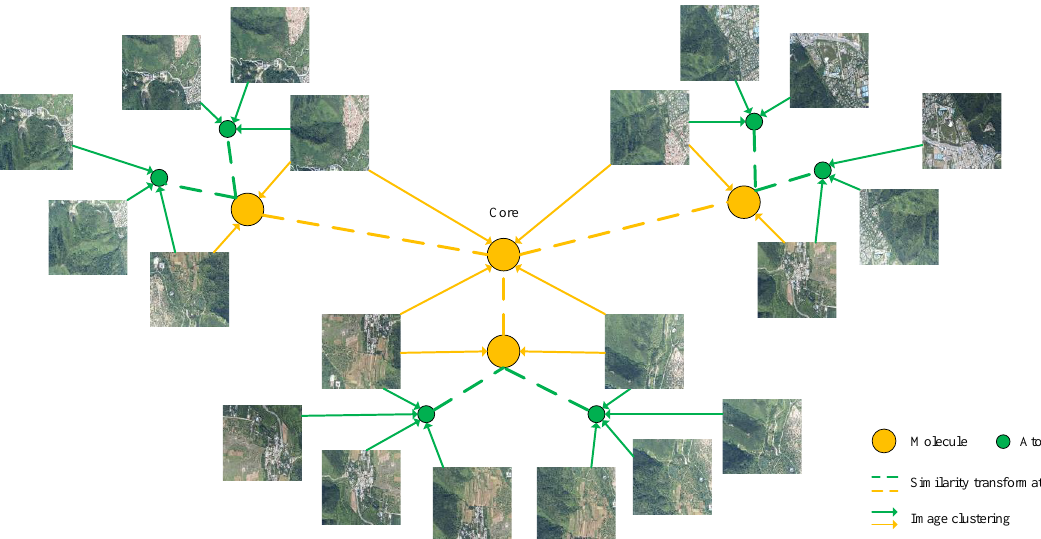
Figure 2. An illustration of the hierarchical atomic model. The green circle and yellow circles represent atoms and molecules, respectively. The solid line represents the image clustering process, and the dashed line denotes the similarity transformation between a pair of atoms and its corresponding molecule or pair of